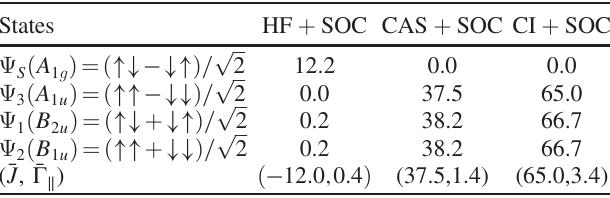
TABLE I. Energy splittings for the four lowest spin-orbit states of two NN IrO 6 octahedra and the corresponding effective coupling constants in Ba214, at different levels of approximation (all in